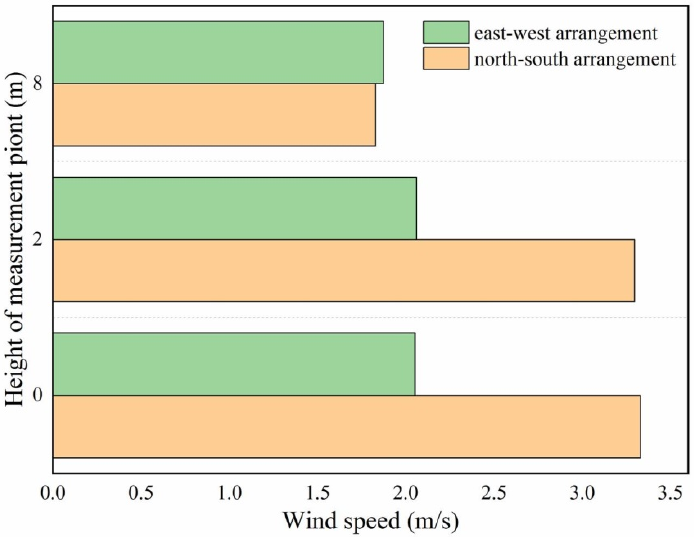
Table 3. Parameters of cultivation racks in the horizontal spacing investigation.